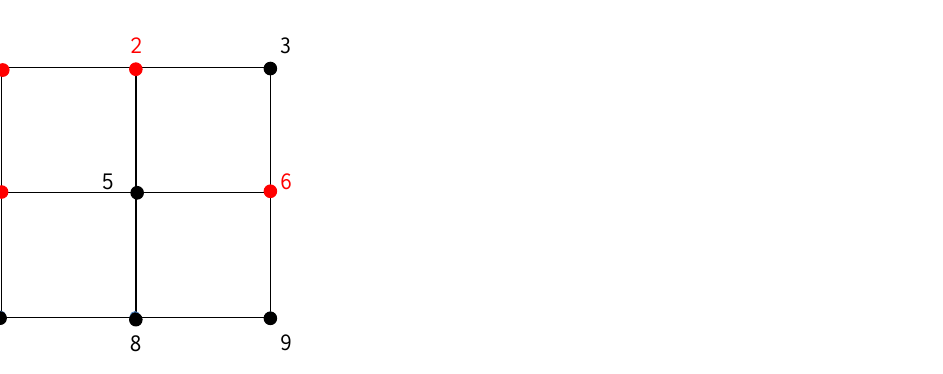
Figure 4. The target configuration for the simulations in R 2 . There are totally 24 edges in the graph without being fully drawn in the figure.